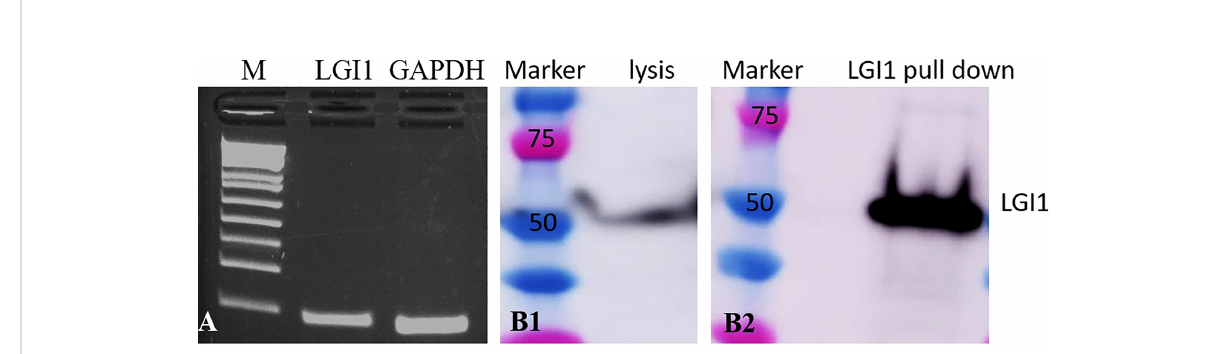
FIGURE 2 Cardiomyocytes express LGI1 mRNA and protein. (A) qt-PCR showing LGI1 and GAPDH (control) mRNA expression in mouse cardiomyocytes; (B) western blot of human heart ventricle lysate demonstrates binding of commercial LGI1 commercial antibodies to ~50 kD protein (B1); immunoprecipitation and western blot screening of human heart ventricle lysates with LGI1 commercial antibody also demonstrates a ~50 kD molecular weight band